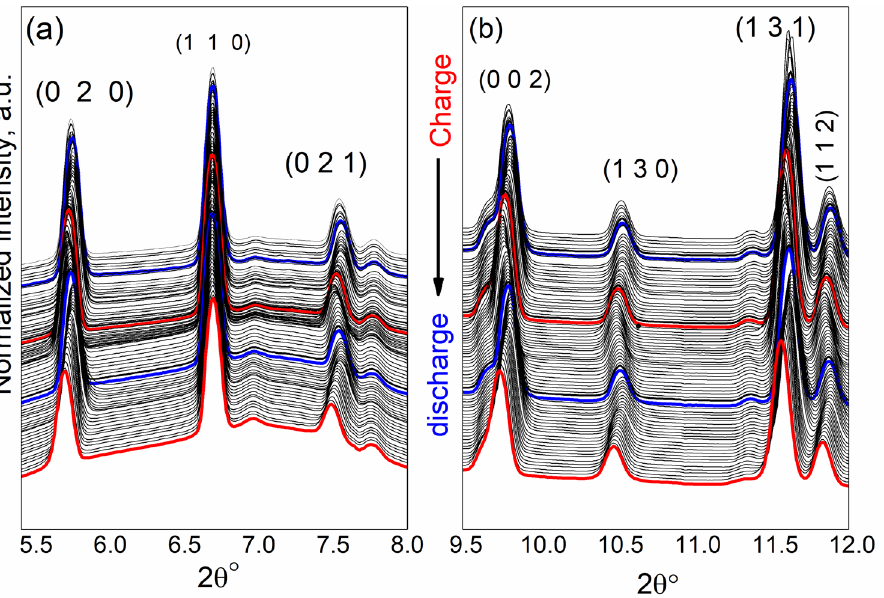
Figure 3. Operando synchrotron XRD patterns of LiCo 0.5 Fe 0.5 PO 4 upon the first two charge–discharge cycles in the 2θ range: ( a ) from 5.3 to 8°, indicating the shift to the lower 2θ values at this region, ( b ) from 9.5 to 12° indicating the shift to lower 2θ values at this region. The red line represents the charging process, and the blue line is the discharge